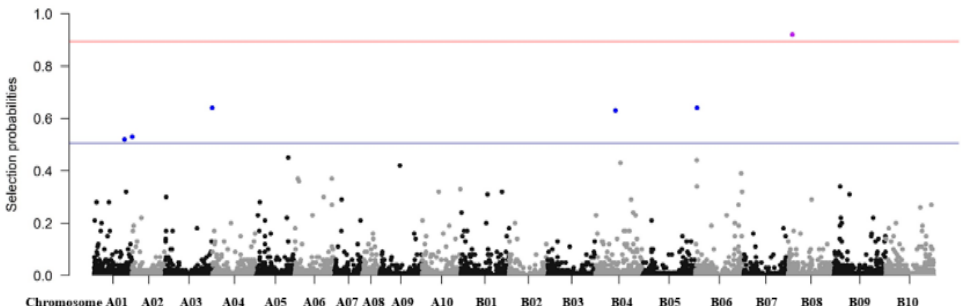
Figure 6. Manhattan plot of a genome-wide association analysis by the least absolute and shrinkage selection operator (LASSO).